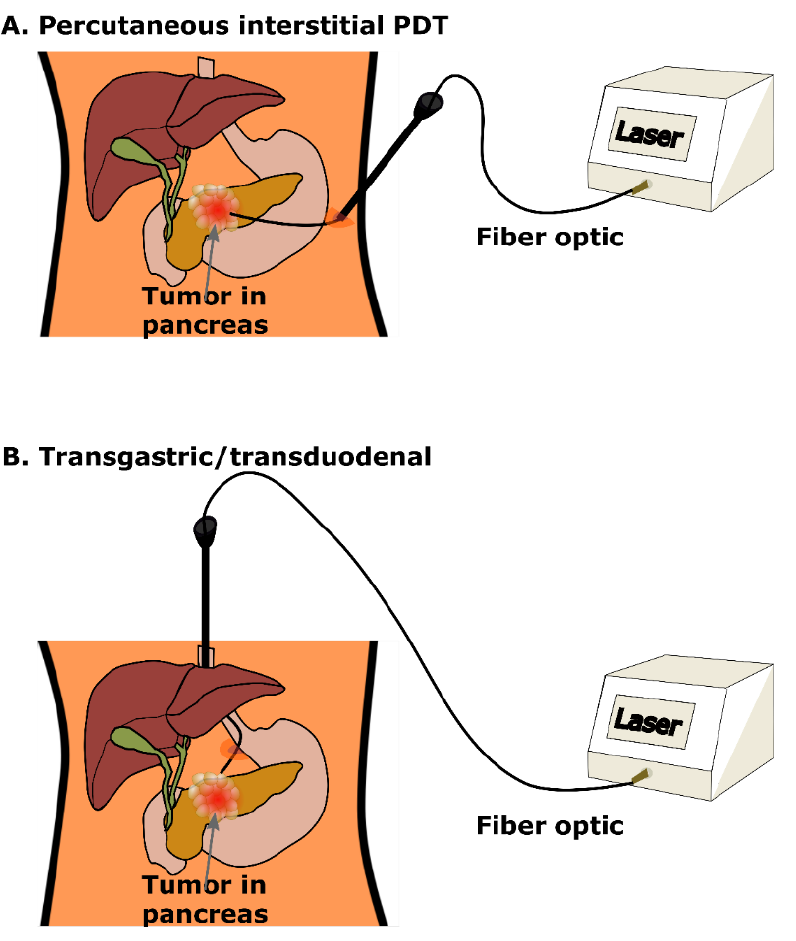
Figure 3. Percutaneous interstitial PDT.